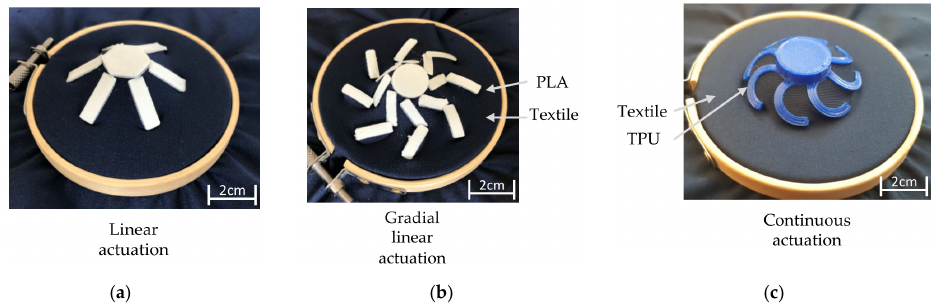
Figure 9. Buttons, clamped in embroidery hoops after printing, as actuators made with 4D textiles: ( a ) linear actuation; ( b ) gradual linear actuation; ( c ) continuous actuation.